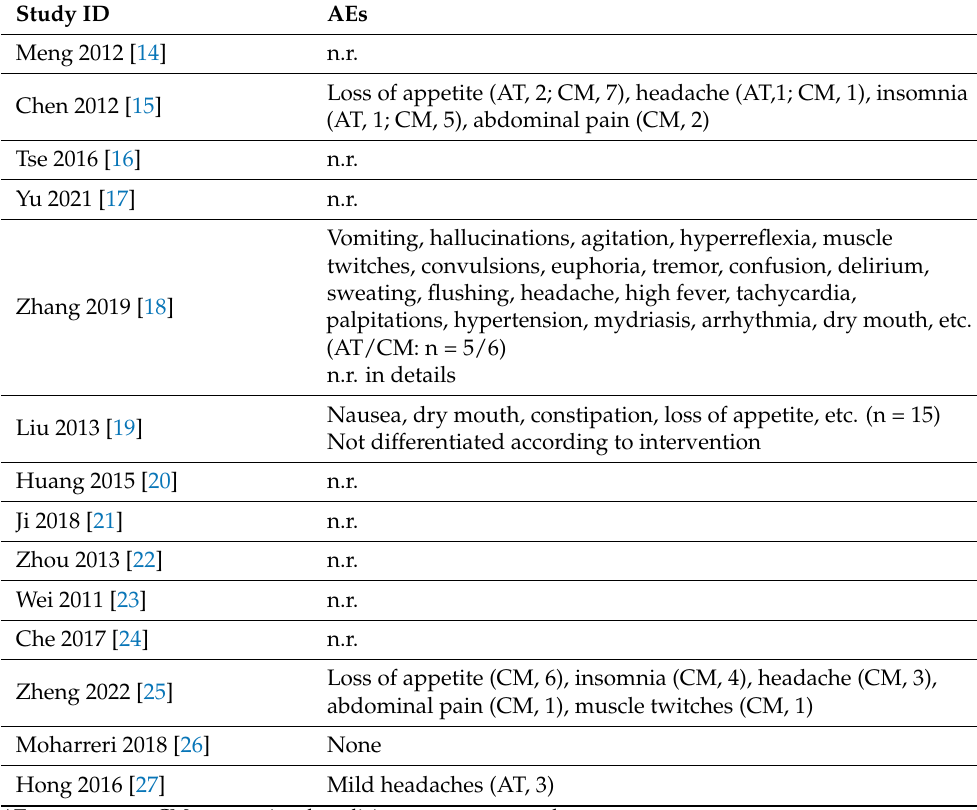
Table 2. Details of the adverse events reported in the included